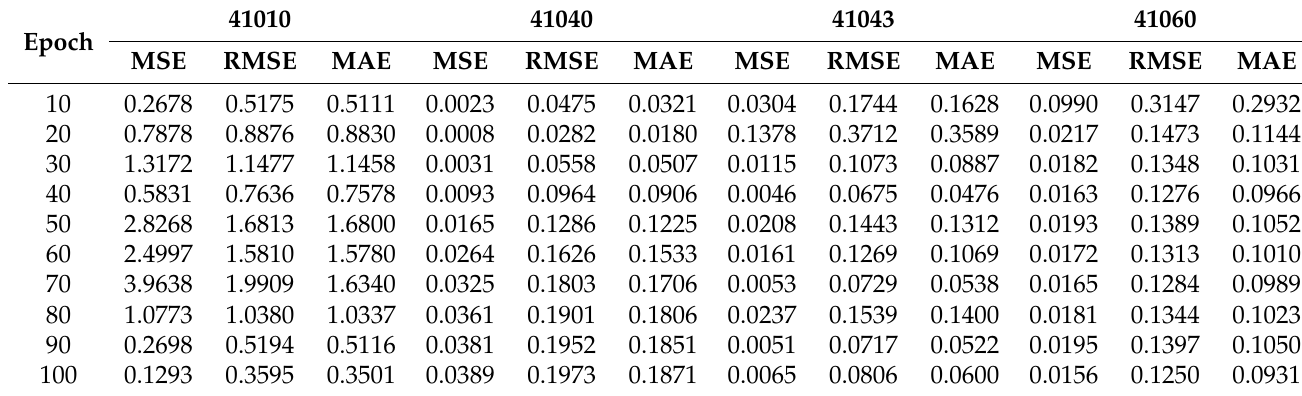
Table 10. Results of the original GTU model in all datasets.